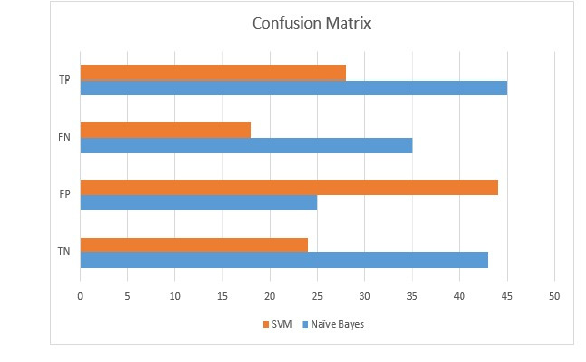
Fig. 16: Confusion Matrix